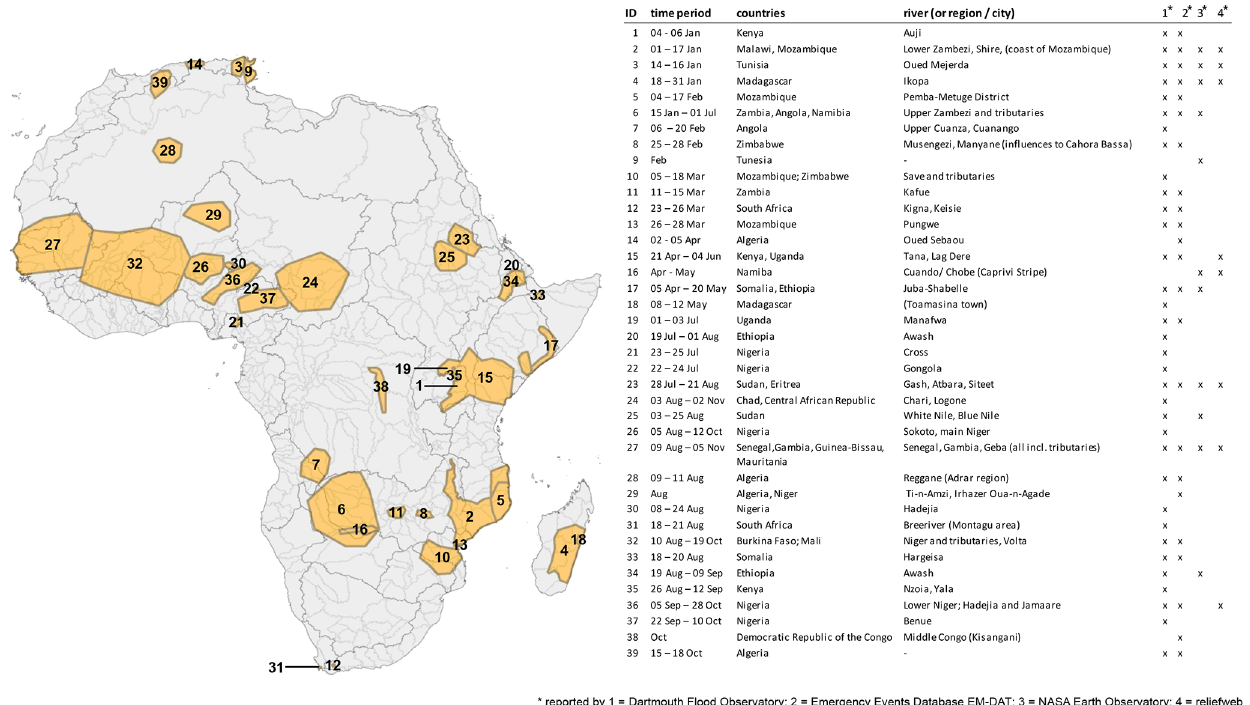
Figure 2. Flood events in Africa, in 2003, as reported by various disaster databases (Dartmouth Flood Observatory, Emergency Events Database (EM-DAT), NASA Earth Observatory and Reliefweb). The map on the left indicates the outline of the affected regions, while the table on the right gives further details on time period and